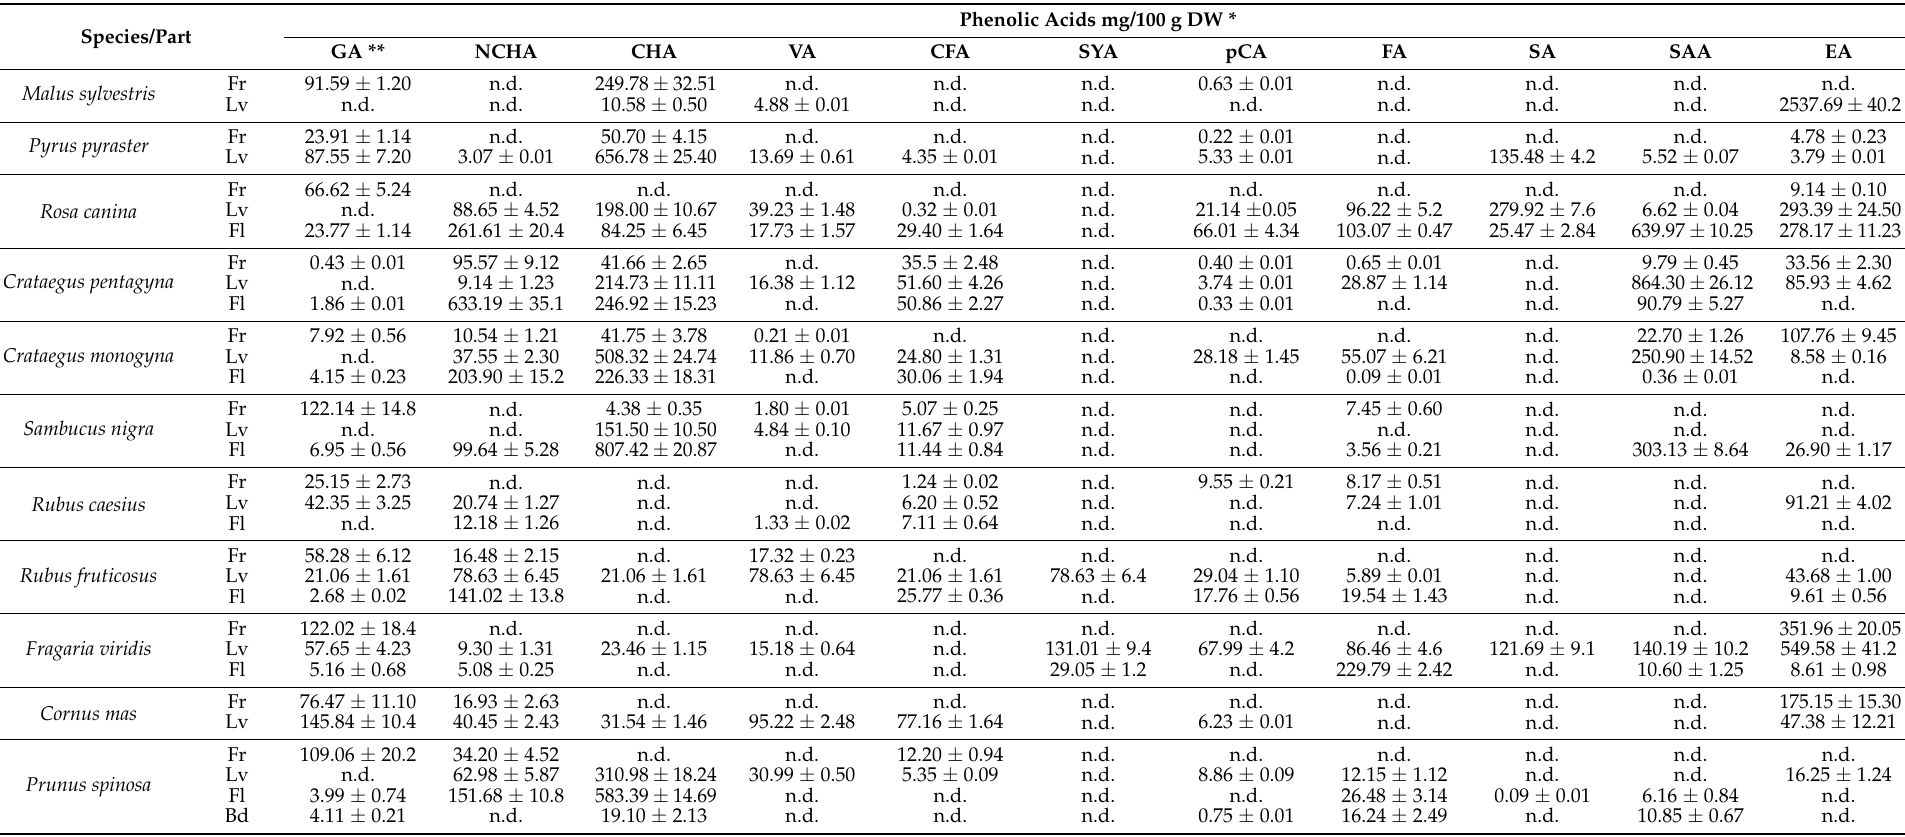
Table 2. Phenolic acid content of studied wild fruit species in different plant